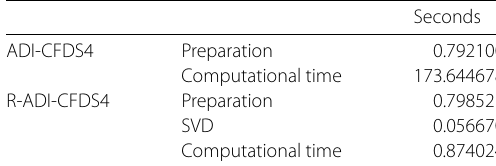
Table 15 The consuming time of two schemes for SP 3 at t = 4, with h x = h y = 0.02 π , τ = 0.02